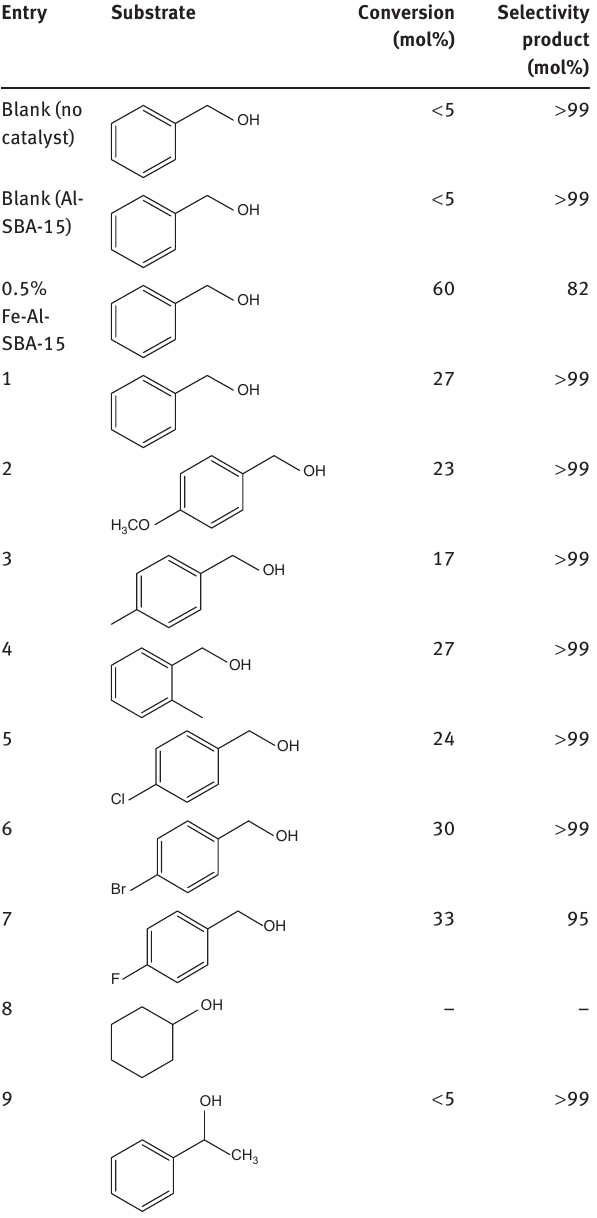
Table 1 Microwave-assisted oxidation of alcohols using 0.5% Co/ Al-SBA-15 catalysts.